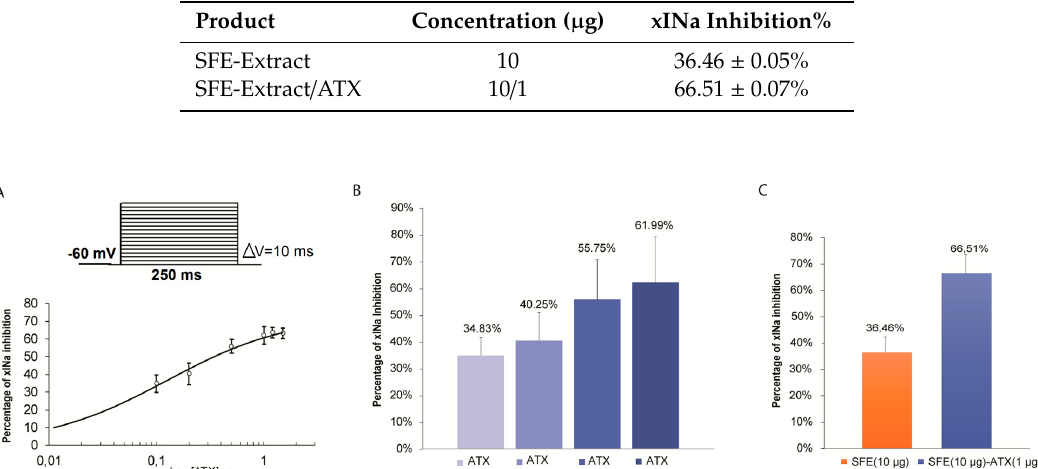
Table 2. Amiloride-sensitive sodium current amplitude variation as a function of SFE-Extract and/or ATX concentrations (4–6 experiments).